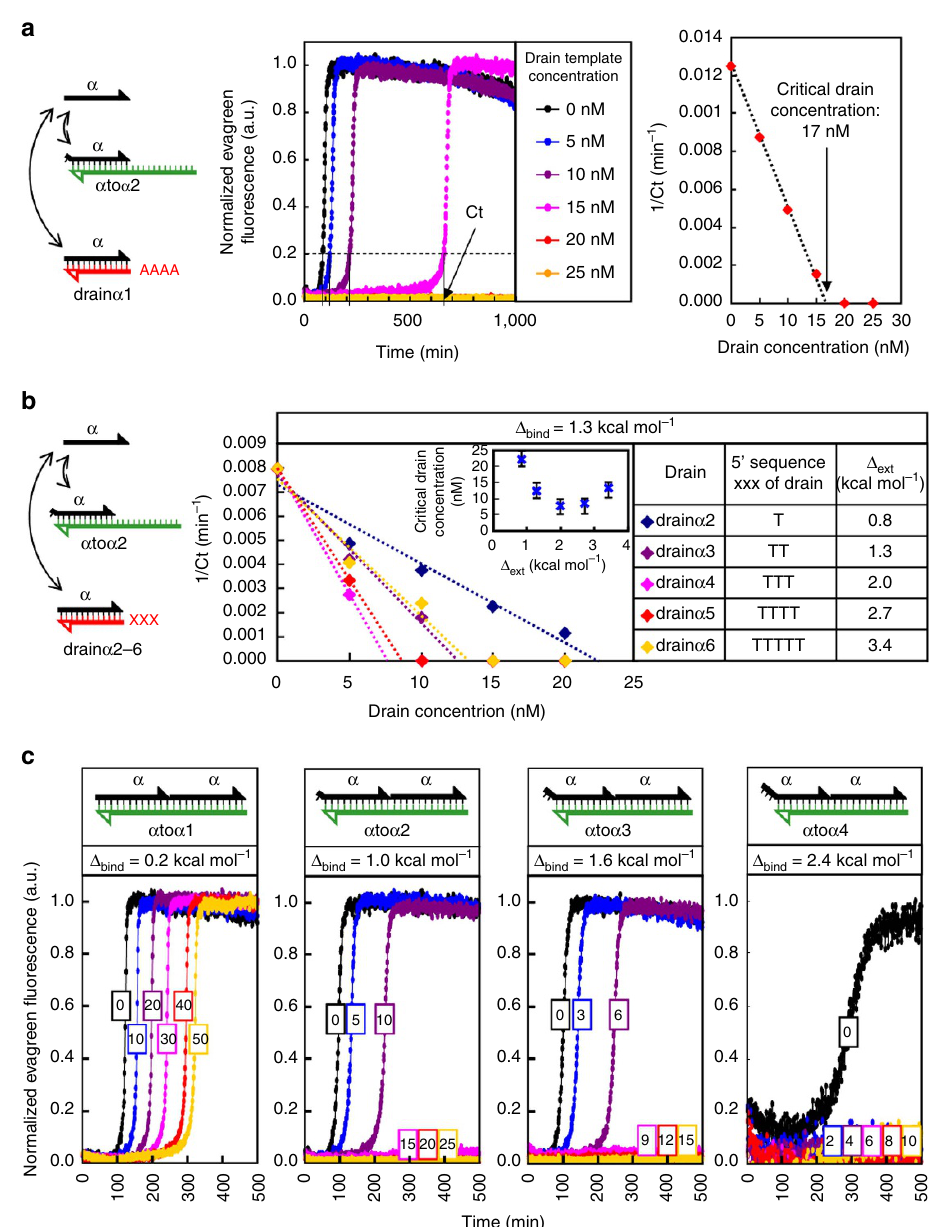
Figure 3 | Experimental implementation. Bst (polymerase), Nb.BsmI (nickase) and ttRecJ (exonuclease) are used to drive an autocatalytic template with or without drains. Fluorescence recordings using an intercalating dye reveal in real time the amplification process. ( a ) The template a to a 2 was incubated without trigger, in the presence of the indicated concentrations of drain template drain a 1 (therefore D bind ¼ 1.0kcalmol (cid:2) 1 and D ext ¼ 2.6kcalmol (cid:2) 1 ). For each sample, the amplification delay ( Ct , set as the time the fluorescence reaches 20% of its normalized maximum) is extracted. The simple autocatalytic network ([drain] ¼ 0) always self-initiates, but increasing concentrations of drain template first delay, then completely abolish this phenomenon. The plot of 1/ Ct versus [drain] reveals the hyperbolic transition to bistability and interpolation yields the critical drain concentration. ( b ) Effect of drain design. To check the influence of D ext on the drain’s inhibitory capacity, autocatalytic template a to a 3 was incubated with varying concentrations of various drains (drain a 2 to drain a 6). These drains all have the same sequence except for the three tailing bases at the 5 0 -end, therefore D ext values range from 0.8 to 3.4kcalmol (cid:2) 1 . The critical drain concentration is estimated by interpolation and reported in the inset with an error bar corresponding to the highest concentration of drain for which spontaneous amplification is observed and the first bistable point, respectively. ( c ) Influence of D bind on the drain’s inhibitory capacity. Autocatalytic templates a to a 1, a to a 2, a to a 3 or a to a 4 (schematized in the upper panels) were incubated in the presence of varying concentrations of drain a 1 (concentrations indicated in the coloured boxes). D bind ranges from 0.2 to 2.4kcalmol (cid:2) 1